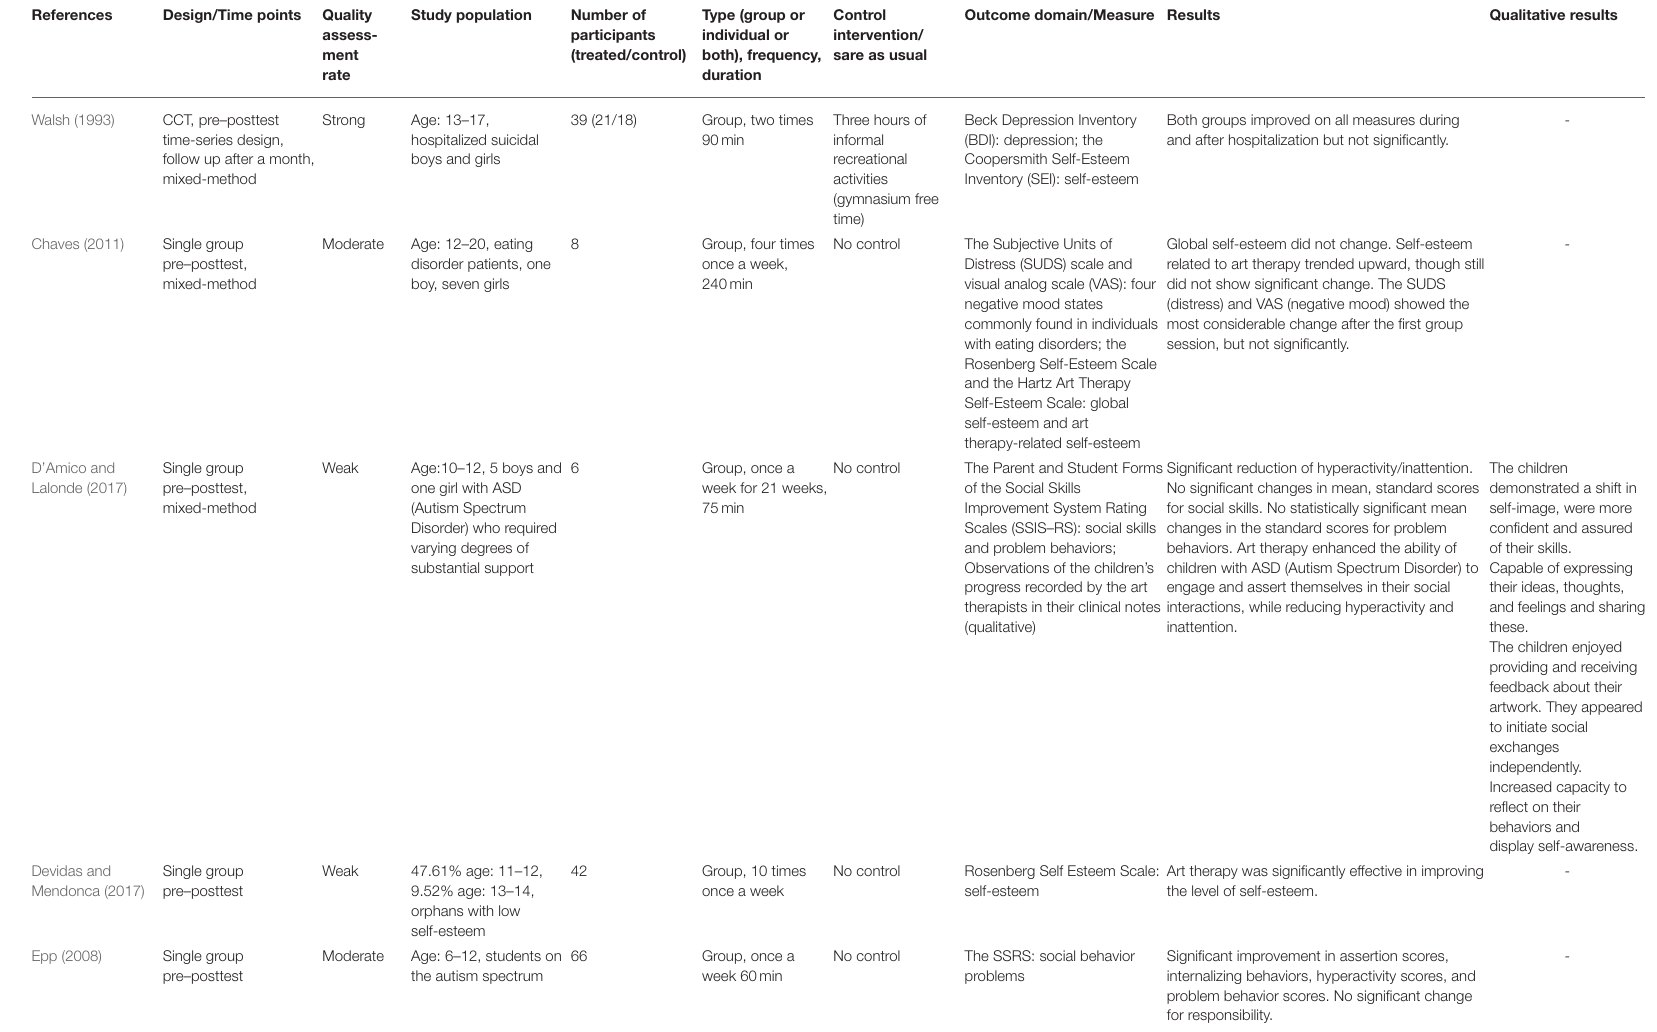
Global self-esteem did not change. Self-esteem related to art therapy trended upward, though still did not show significant change. The SUDS (distress) and VAS (negative mood) showed the most considerable change after the first group session, but not significantly.